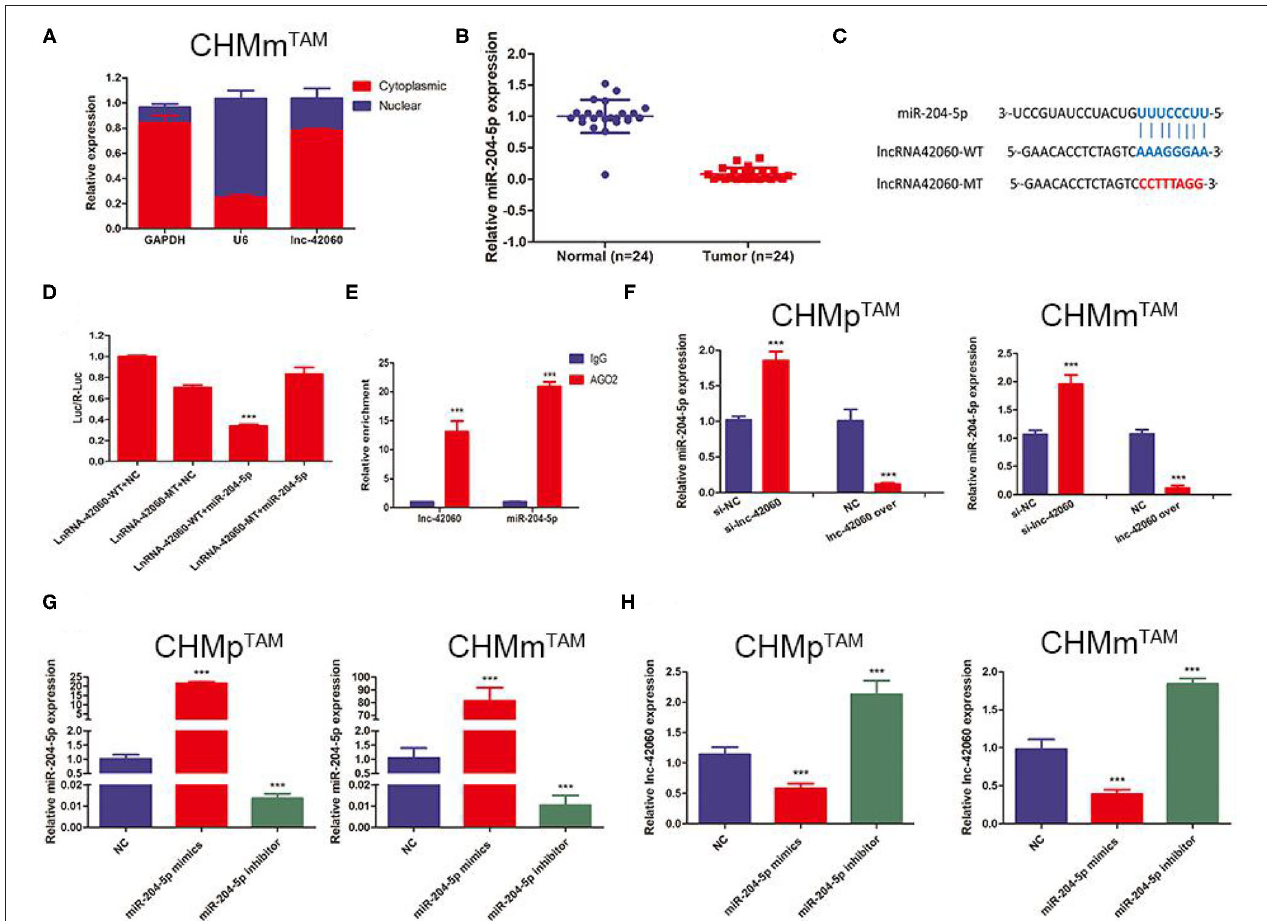
FIGURE 4 | lnRNA-42060 acts an efficient miRNA sponge for miR-204-5p. (A) Expression of lnc-42060 in the nucleus and cytoplasm by qRT-PCR. (B) Expression of miR-204-5p in CMGT and normal tissues by qRT-PCR. (C) The predicted potential binding sites of miR-204-5p to lnc-42060 and schematic of WT and MUT of lnc-42060. (D) Dual-luciferase reporter assay revealed that miR-204-5p reversely controlled the luciferase activity of lnc-42060-WT, rather than MT. (E) The lnc-42060 and miR-204-5p levels isolated from Ago2 and IgG immunoprecipitates derived from CHMm TAM cells were examined by quantitative real-time PCR. (F–H) Expression of lnc-42060 or miR-204-5p by qRT-PCR. Data are presented as means ± SD of at least three independent experiments. Compared with control group, *** P <